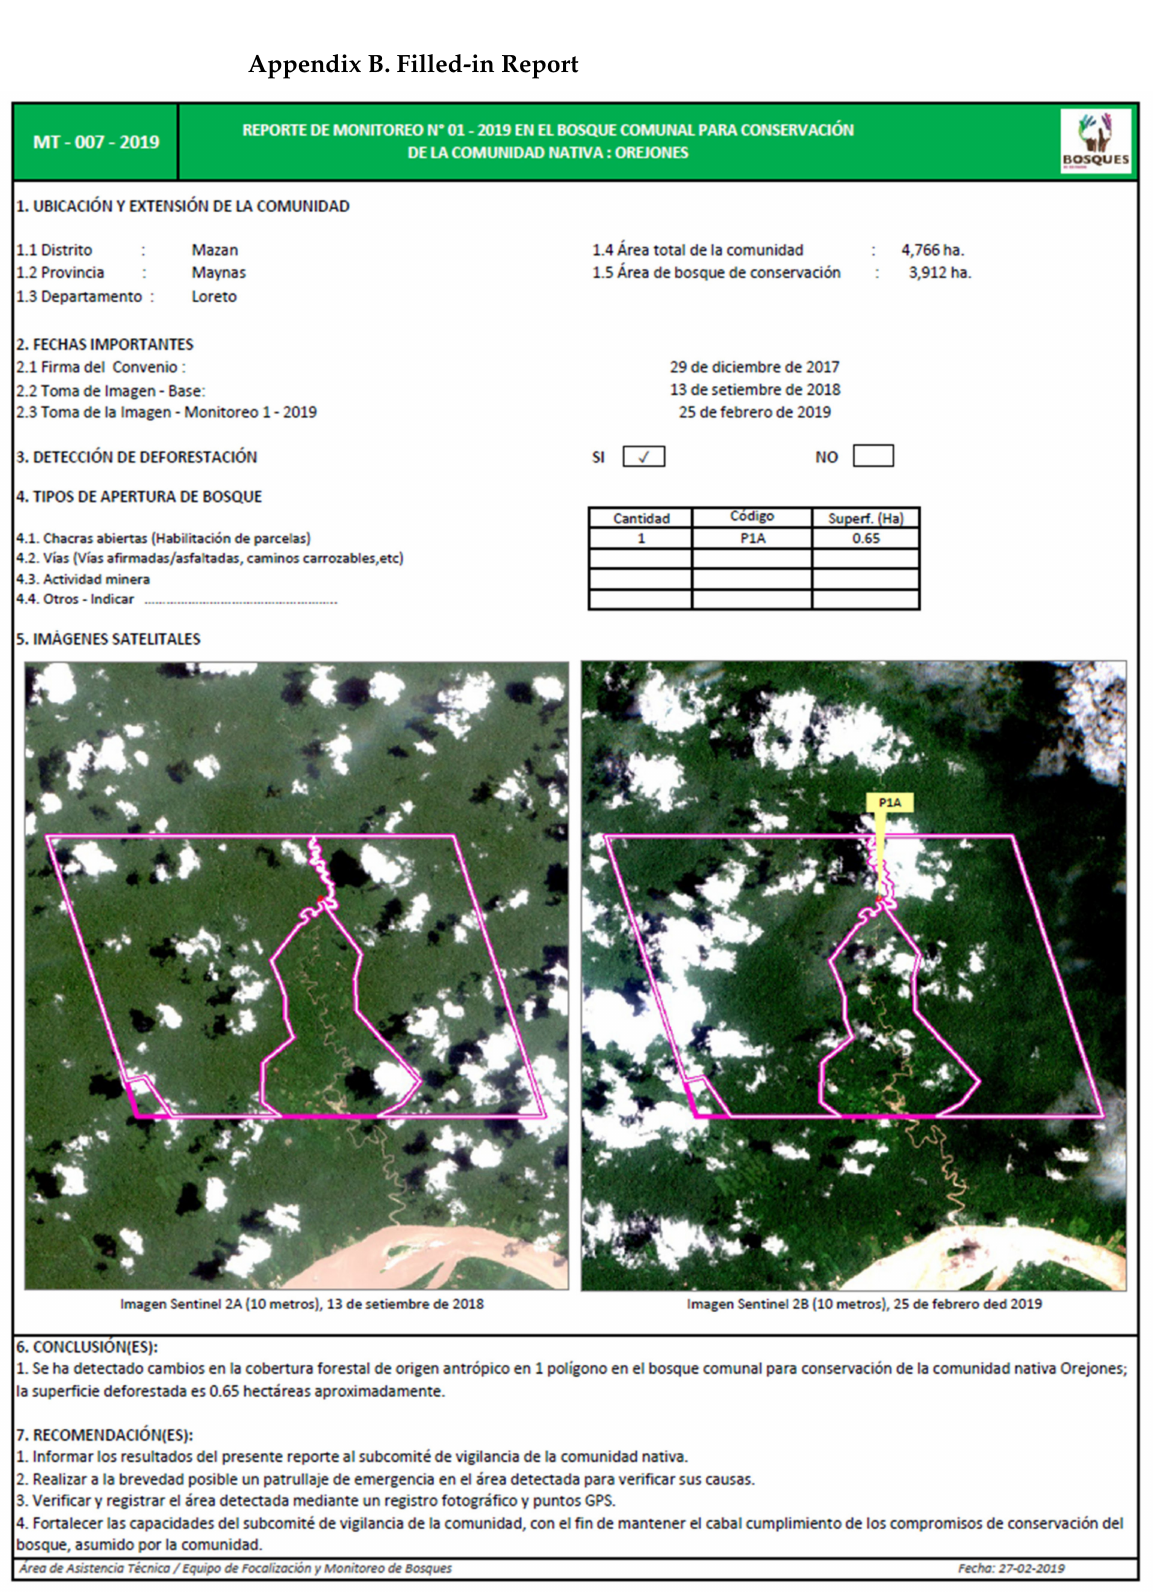
Figure A2. Monitoring report N ◦ . 01–2019 in the communal forest for conservation from the native community: